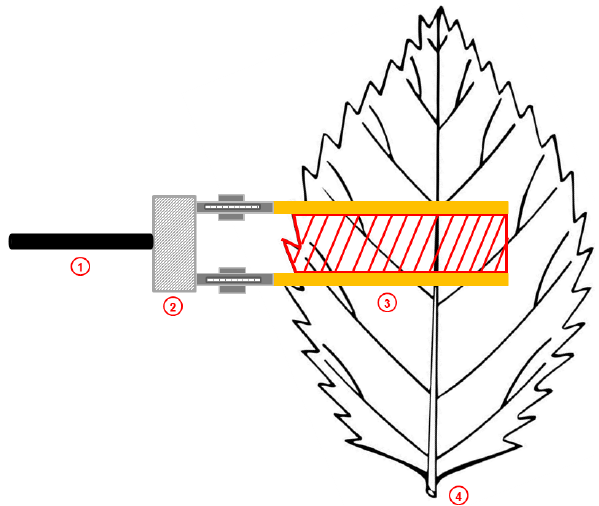
Figure 4. Draft of the leaf wetness sensor. 1 – data cable; 2 – sensor; 3 – electrode clams; 4 – plant leaf. Modified from Burkhardt and Gerchau